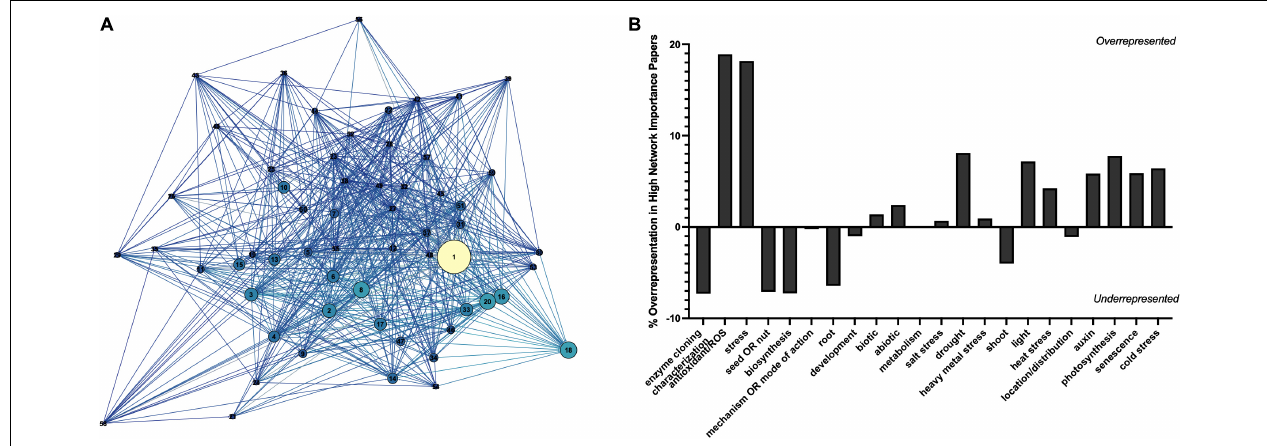
FIGURE 10 | Network analysis by digital object identifier (DOI) (A) and representation of studies in the plant melatonin literature (B) . Correlation network shows relationship between top cited DOIs filtered to an in-degree cutoff of > 100. Increasing node size indicates higher page rank (network importance), nodes are colored based on in-degree, the greater the number of articles citing the lighter the color. Key can be found in Supplementary Figure 3 .